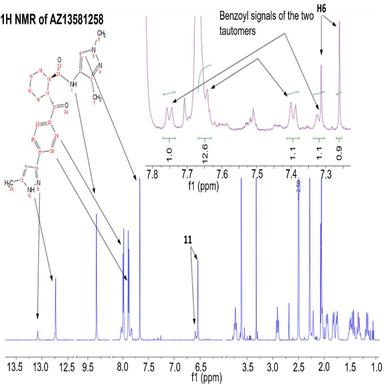
1H NMR spectrum of AZ13581258. Full spectrum: arrows indicating the subsets of the N-H equilibrium in the pyrazole ring. Expansion showing the aromatic signals from the two tautomeric forms of AZ13581258.